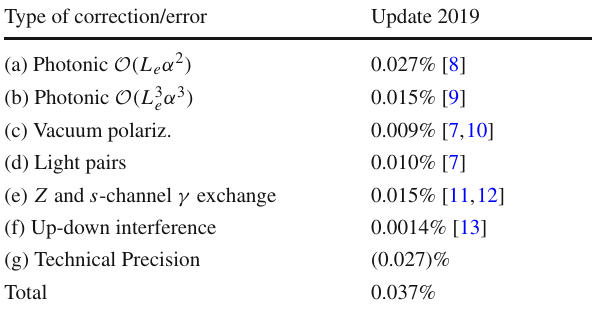
Table 2 Summary of the total (physical+technical) theoretical uncer- tainty for a typical calorimetric LEP luminosity detector within the generic angular range of 18–52 mrad. Total error is summed in quadra-